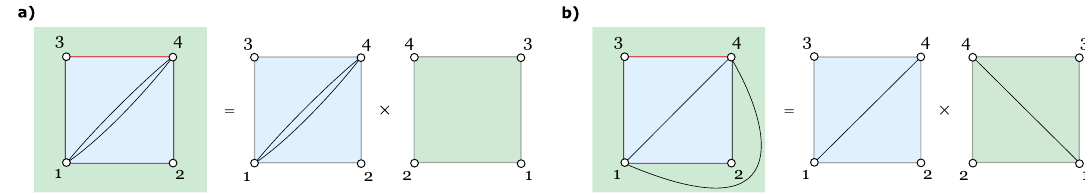
Figure 8 . Factorization of the contributions corresponding to a certain skeleton diagram. The interior and exterior of the square frame are identified with two octagons that decouple in the null-square limit. a) and b) correspond to the first two diagrams of figure 7.